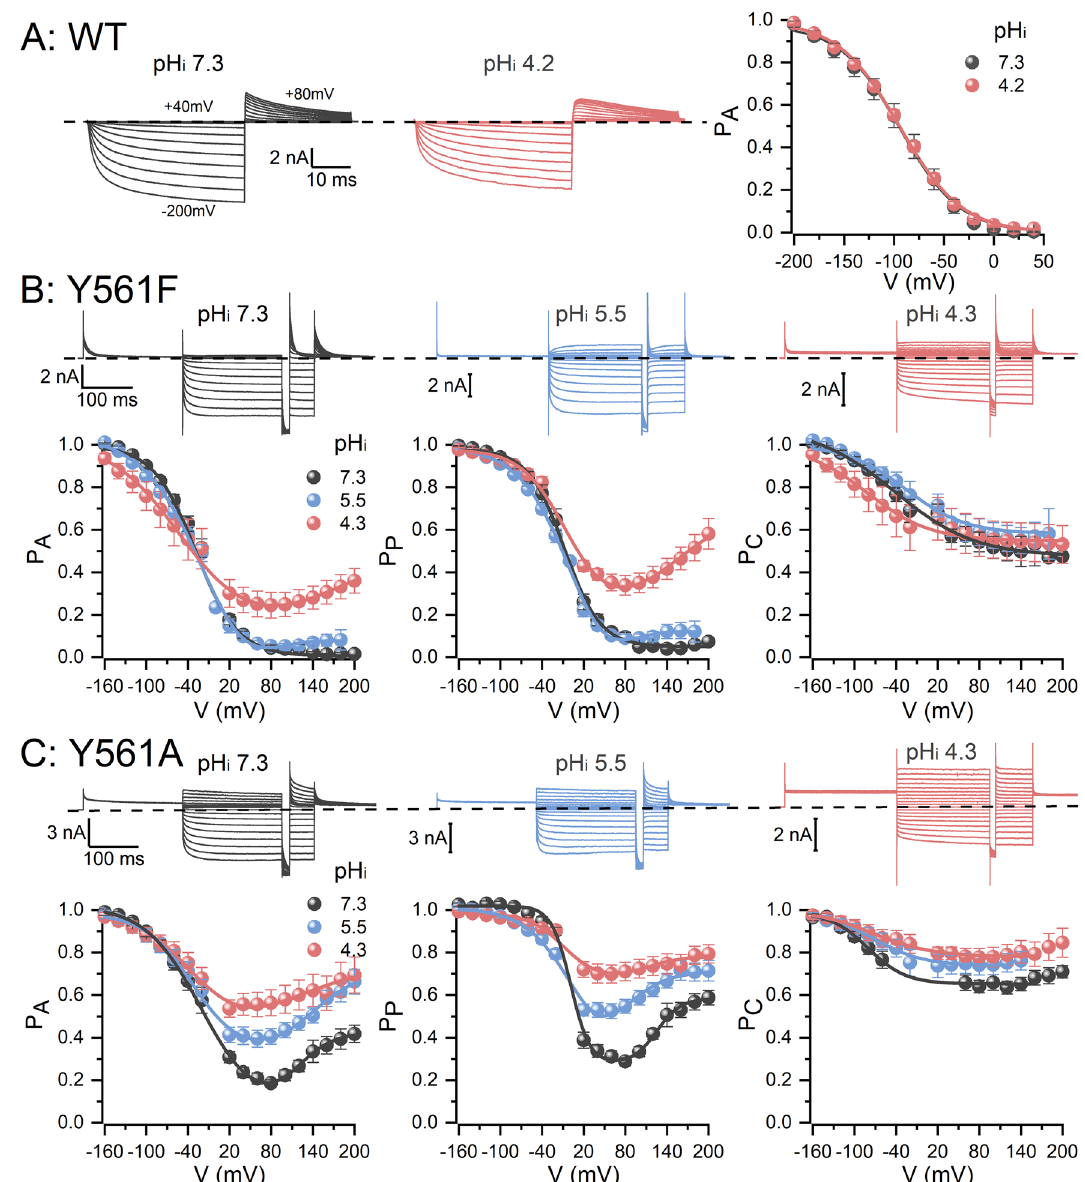
Figure 6. Y561F and Y561A CLC-2 mutant channels are sensitive to intracellular protons. (A) Intracellular acidification did not alter the voltage dependence of WT CLC-2 P A . Recordings like those shown on the left side were analysed to construct P A vs V relations at pH i of 7.3 (grey) and 4.2 (red). The voltage-dependent parameters V 0.5 were -93.9 ± 7.9 mV and -93.4 ± 3.4 mV, at pH i 7.3 and 4.2, respectively (n = 5). (B,C) Top panels. Cl − currents from three different HEK293 cells expressing the Y561F (B) or Y561A (C) mutants were recorded in the presence of 140 mM intracellular Cl − and intracellular pH 7.3 (grey), 5.5 (blue), 4.3 (red). The voltage protocol showed in Fig. 2A was utilized in these experiments. Extracellular pH and [Cl − ] o were 7.3 and 140 mM, respectively. (B,C) Bottom panels. Voltage dependence of P A , P P and P C for Y561F (B) and Y561A (C) are plotted using data collected at pH i 7.3 (grey), 5.5 (blue) and 4.3 (red). Lines in (A–C) plots are fits of the data with a single (P A in A ; P A and P P at pH i 7.3 and 5.5 and P C in B ; P C in C ) or double (P A and P P at pH i 4.3 in B ; P A and P P in C ) Boltzmann equation used to calculate V 0.5 and z parameters listed in Table